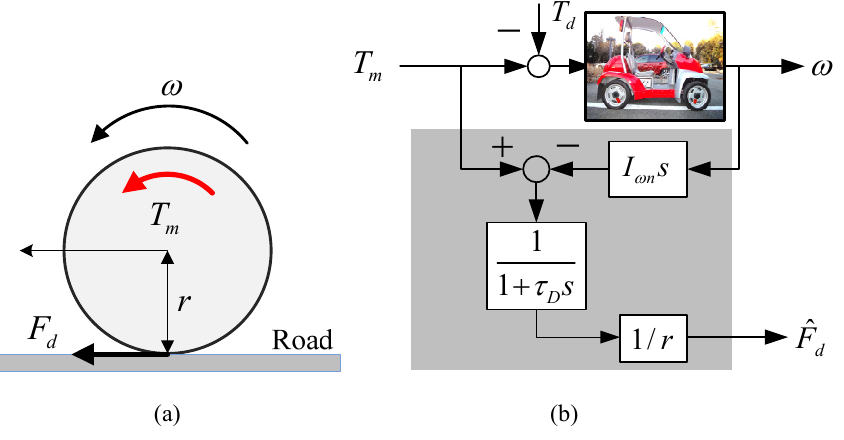
Figure 6. ( a ) Rotational wheel dynamics model. ( b ) Structure of a driving force